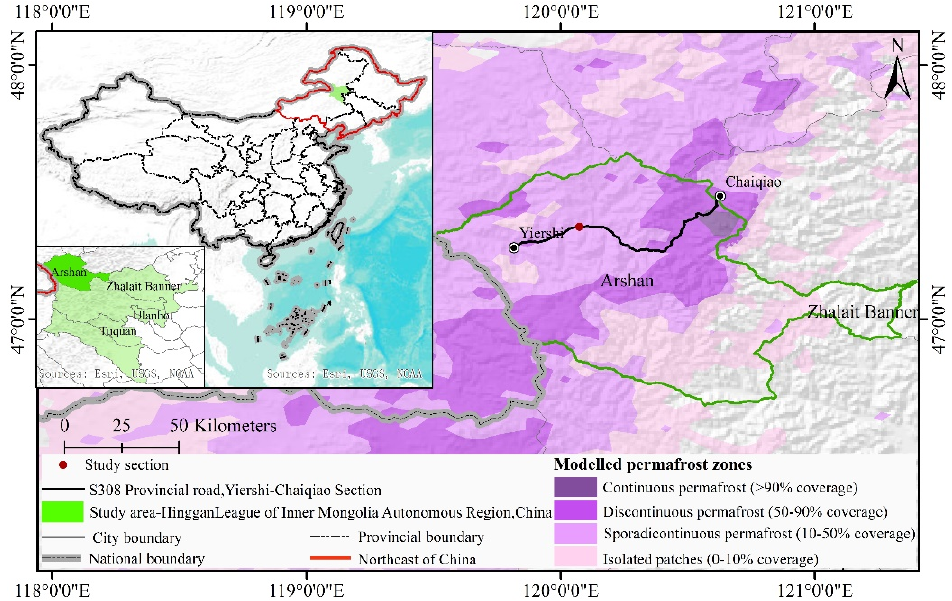
Figure 1. The permafrost distribution in Northeast China and the study area and project location in this paper, data from Jaroslav O. et al., 2019